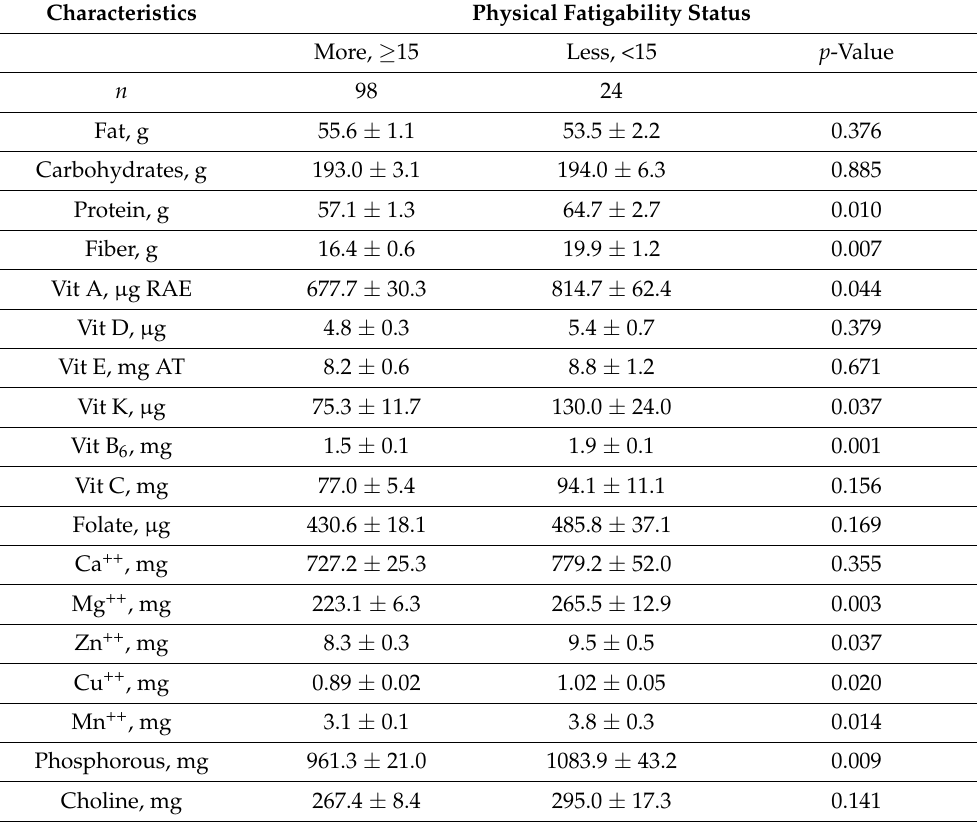
Table 3. Adjusted macro- and micronutrient intake data in a subset of 122 oldest-old participants from the Geisinger Rural Aging Study according to perceived physical fatigability status: Pittsburgh Fatigability Scale